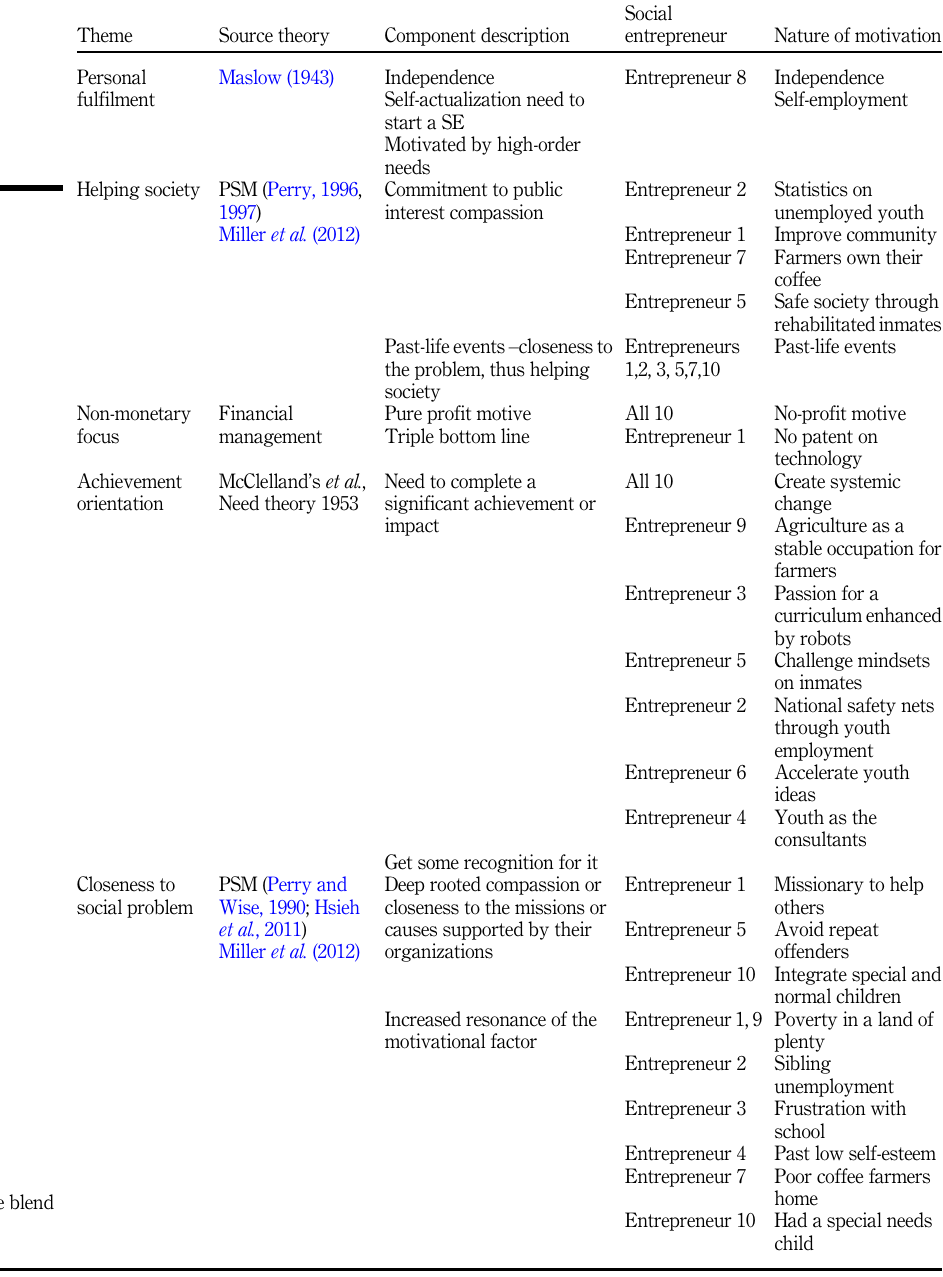
Table 2. Findings on the blend of motivational